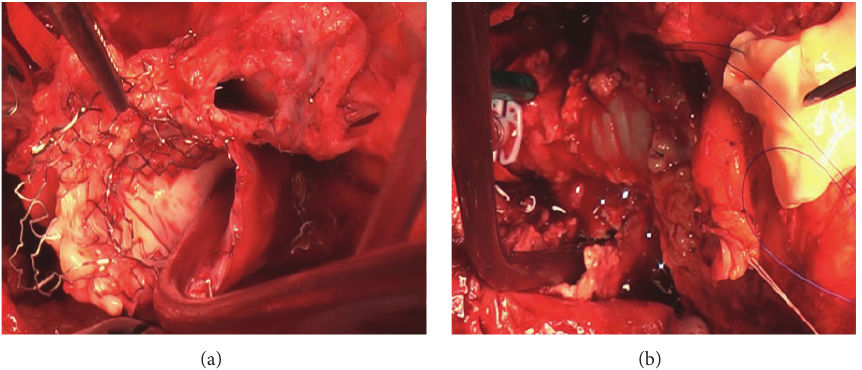
Figure 2: Large aortopulmonary fistula originating from the proximal part of the RPA stent (a); patch closure of the defect (b).